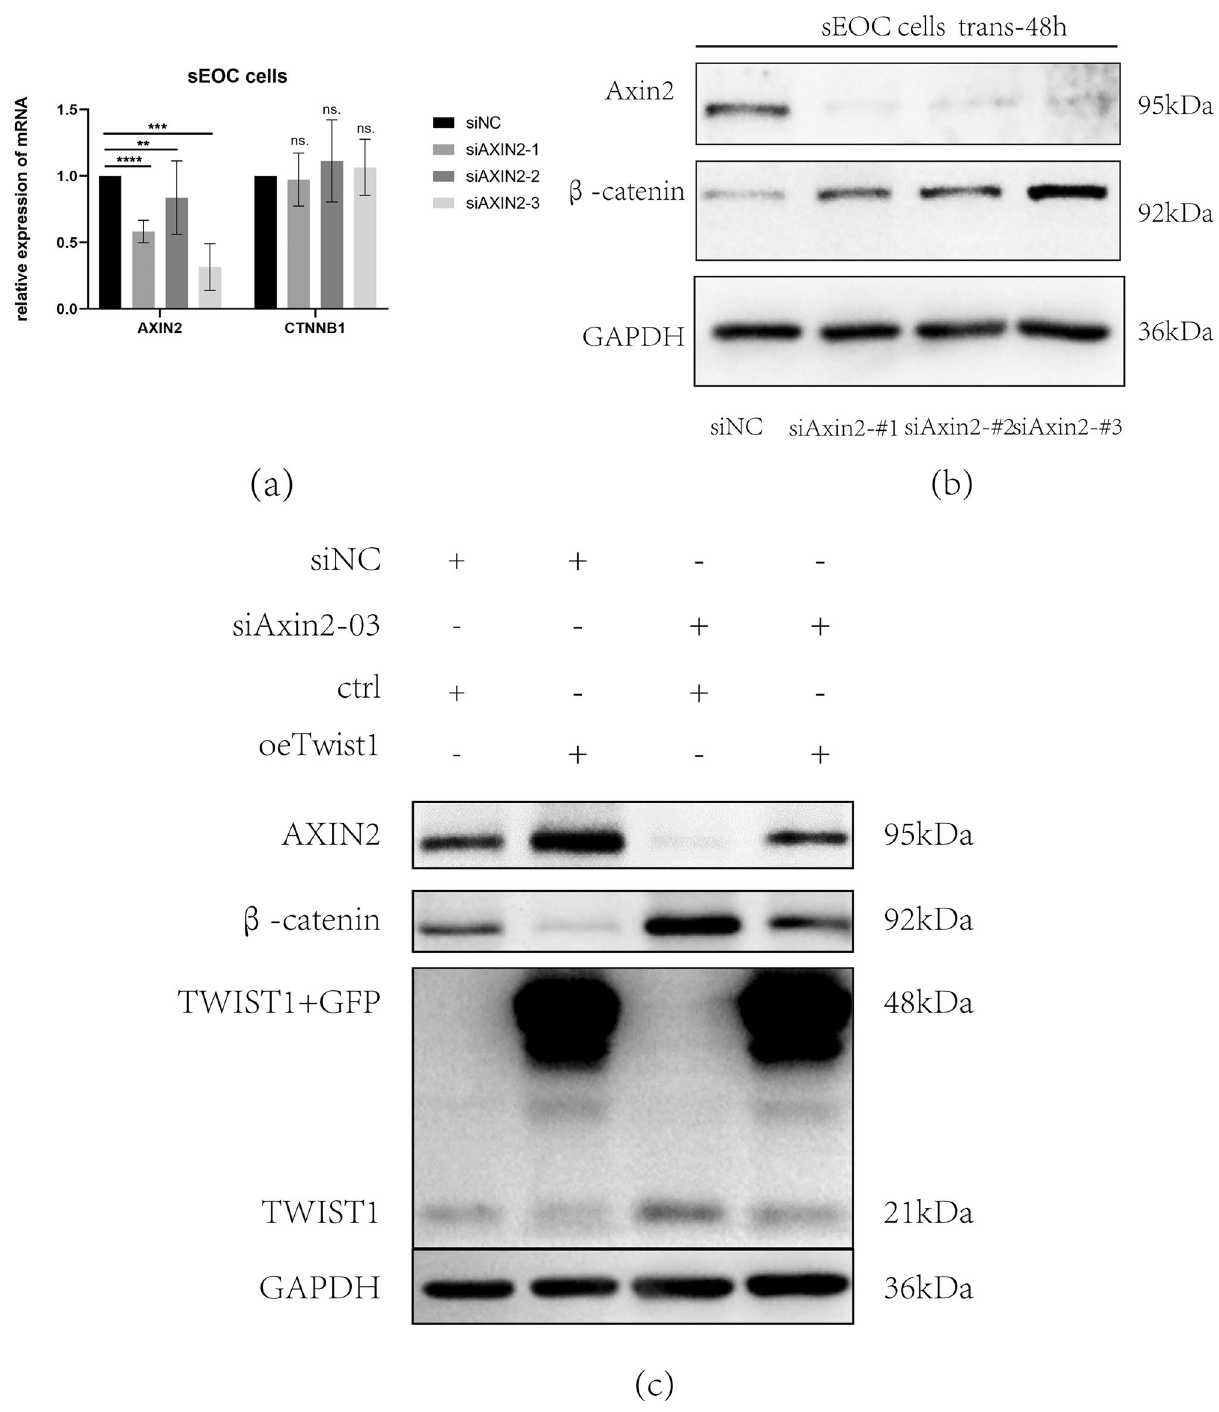
Figure 5. AXIN2 promotes the degradation of β-catenin. ( a ) Efficiency of AXIN2 knockdown and mRNA level of CTNNB1 in sEOC cells. **** p ,*** p ,** p < 0.05, Student’s t test. ( b ) Expression of AXIN2 and β-catenin at the protein level after AXIN2 knockdown in sEOC cells. ( c ) Expression of AXIN2, β-catenin and TWIST1 after transfection with siAXIN2 and TWIST1. Data are representative of three independent